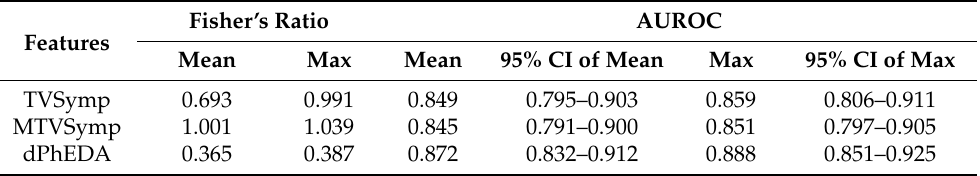
Table 6. Statistical analysis on difference between painless and pain segments for TG